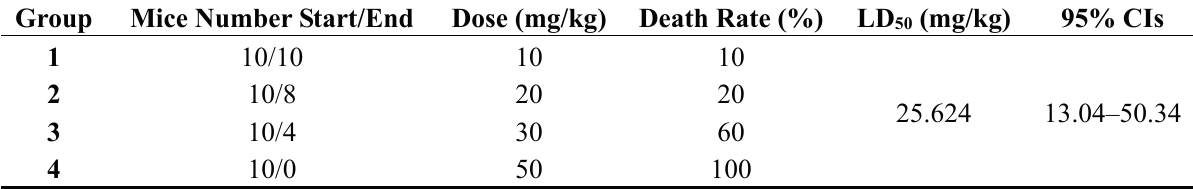
Table 3. Results of S-CA on mortality of acute toxicity test in